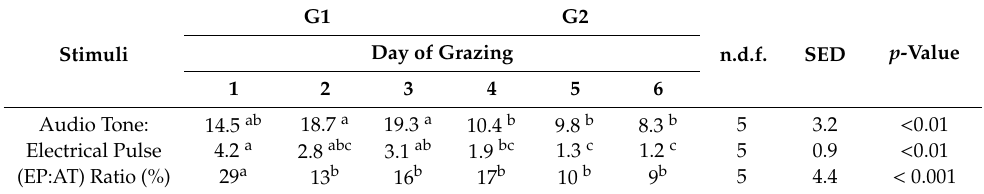
Table 4. Model-predicted means for number of audio tones and electrical pulses delivered across each day of grazing. Number of degrees of freedom (n.d.f.) and standard error of the difference (SED) are presented. a,b,c Indicates significant difference in mean number of audio tones delivered between locations.